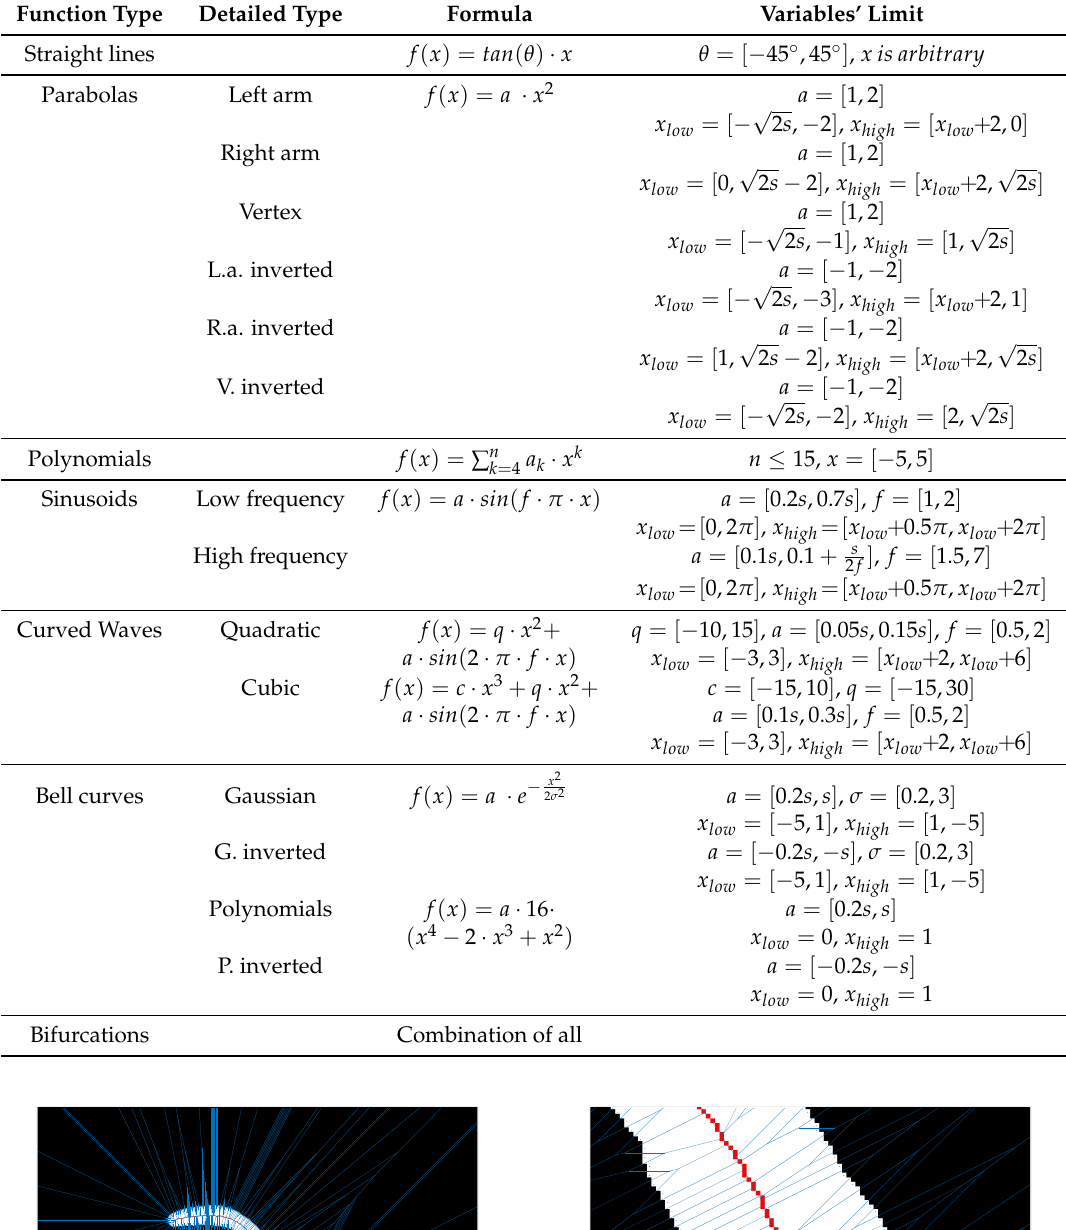
Table 1. Mathematical function, their formula and variables [25].